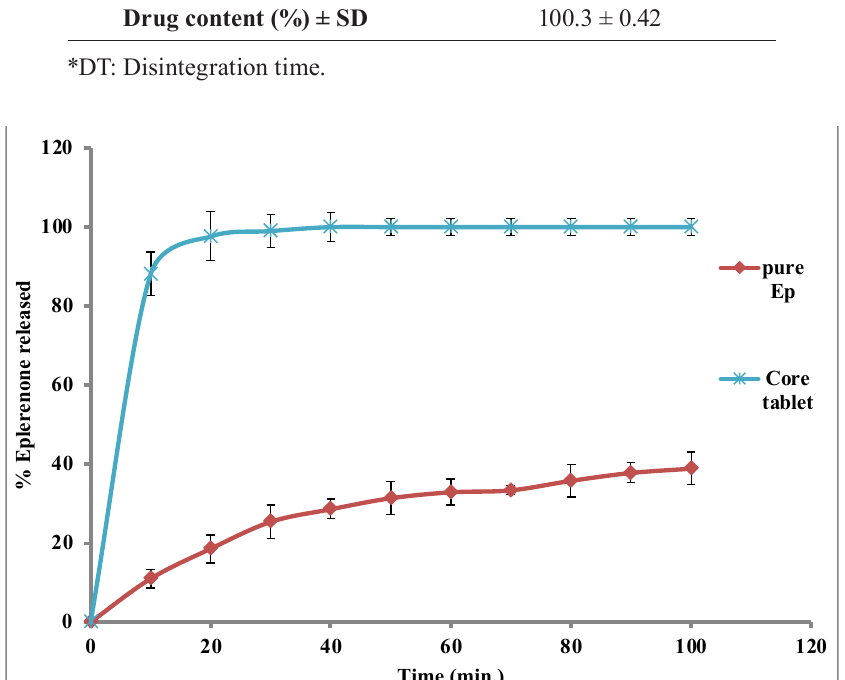
FIGURE 4 - In-vitro dissolution of pure Eplerenone and Eplerenone from core tablets prepared by the inclusion complex. Post compression evaluation of eplerenone press- coated